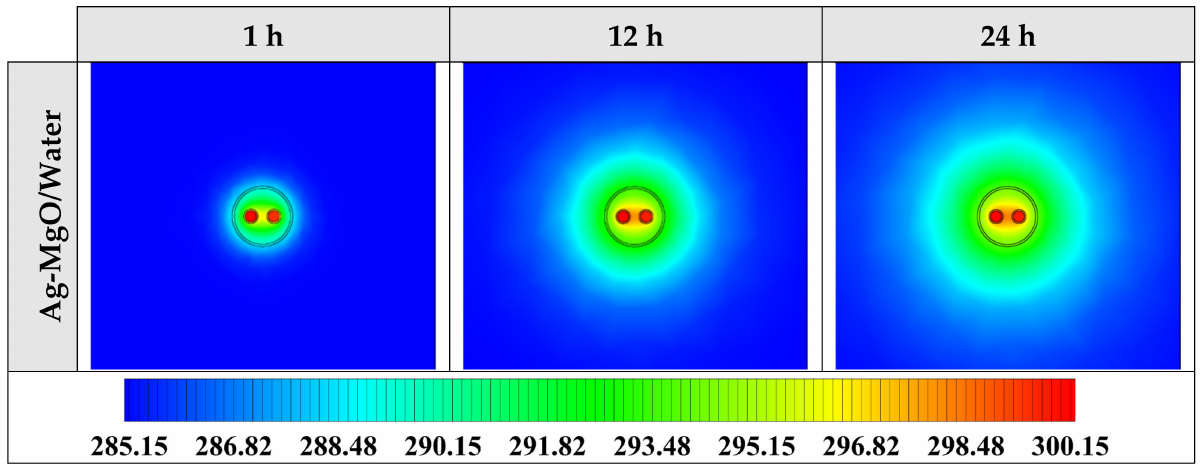
Figure 9. Two-dimensional (2D) contours of the temperature distribution of the BHE at various hours of operating using Ag-MgO/water hybrid nanofluid when φ = 0.15 and Re = 3200 (Top view at Z =